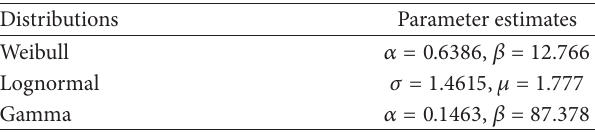
Table 5: Parameter estimates of the fitted probability models.